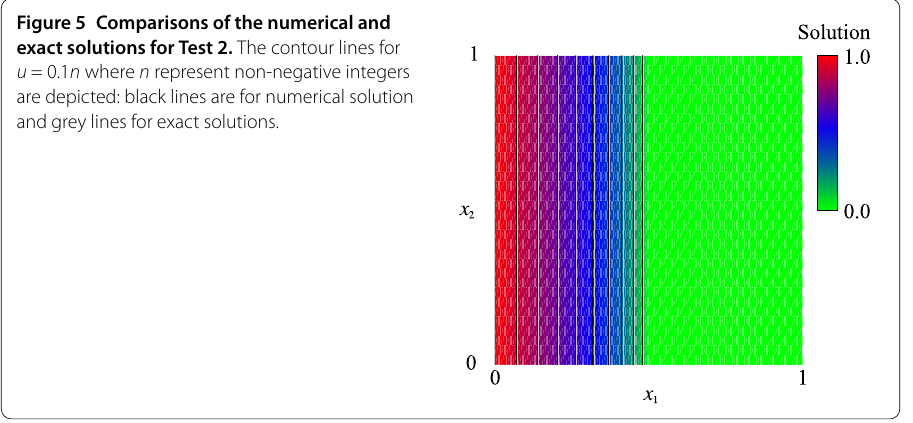
Figure 5 Comparisons of the numerical and exact solutions for Test 2. The contour lines for u = 0.1 n where n represent non-negative integers are depicted: black lines are for numerical solution and grey lines for exact solutions.